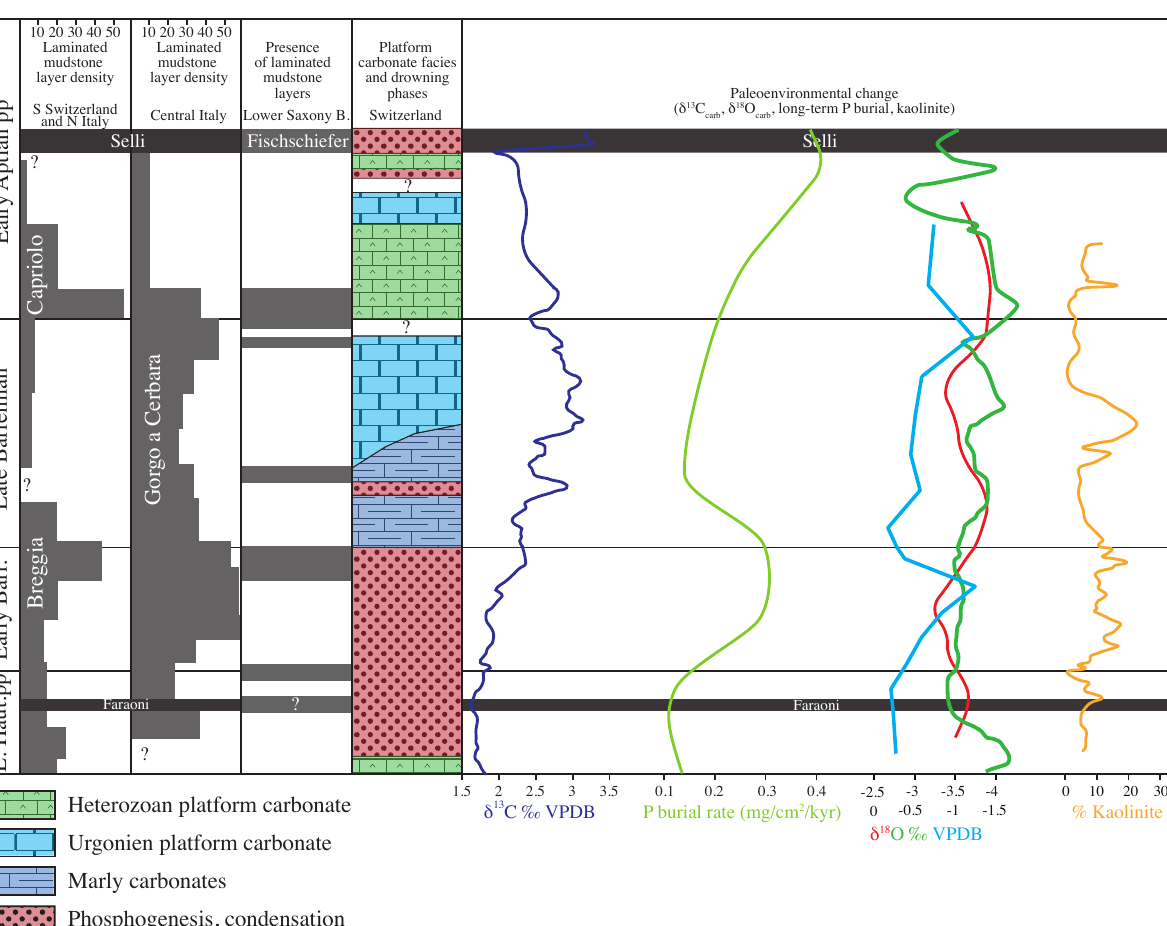
Fig. 10. From left to right: calculated laminated mudstone layer density for the Breggia and Capriolo sections; estimated laminated mudstone layer density for the Gorgo a Cerbara section using the stratigraphic logs from Gorin and Fiet (2000) and Stein et al. (2011); occurrence of laminated mudstone layers in the Lower Saxony Basin: the Barremian and Aptian occurrences are from the basin margin (Mutterlose et al., 2010) and the Hauterivian occurrence from the basin centre (Mutterlose et al., 2009); evolution of the Helvetic segment of the northern Tethyan carbonate platform (modified after F¨ollmi et al., 2007); δ 13 C record on whole-rock carbonate, from the Cismon outcrop and Cismon Apticore (Menegatti et al., 1998; Erba et al., 1999); low-resolution phosphorus burial record (F¨ollmi, 1995; Bodin et al., 2006a); δ 18 O records from whole-rock carbonate from central Italy (in green; Sprovieri et al., 2006; Stein et al., 2011) and southeast France (in red; Godet et al., 2006; Bodin et al., 2009) and δ 18 O record from belemnites from southeastern France (in blue; Bodin et al., 2009); and kaolinite record from southeastern France (Godet et al.,